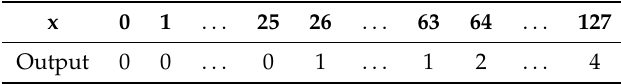
Table 1. Sampled values given random input value.